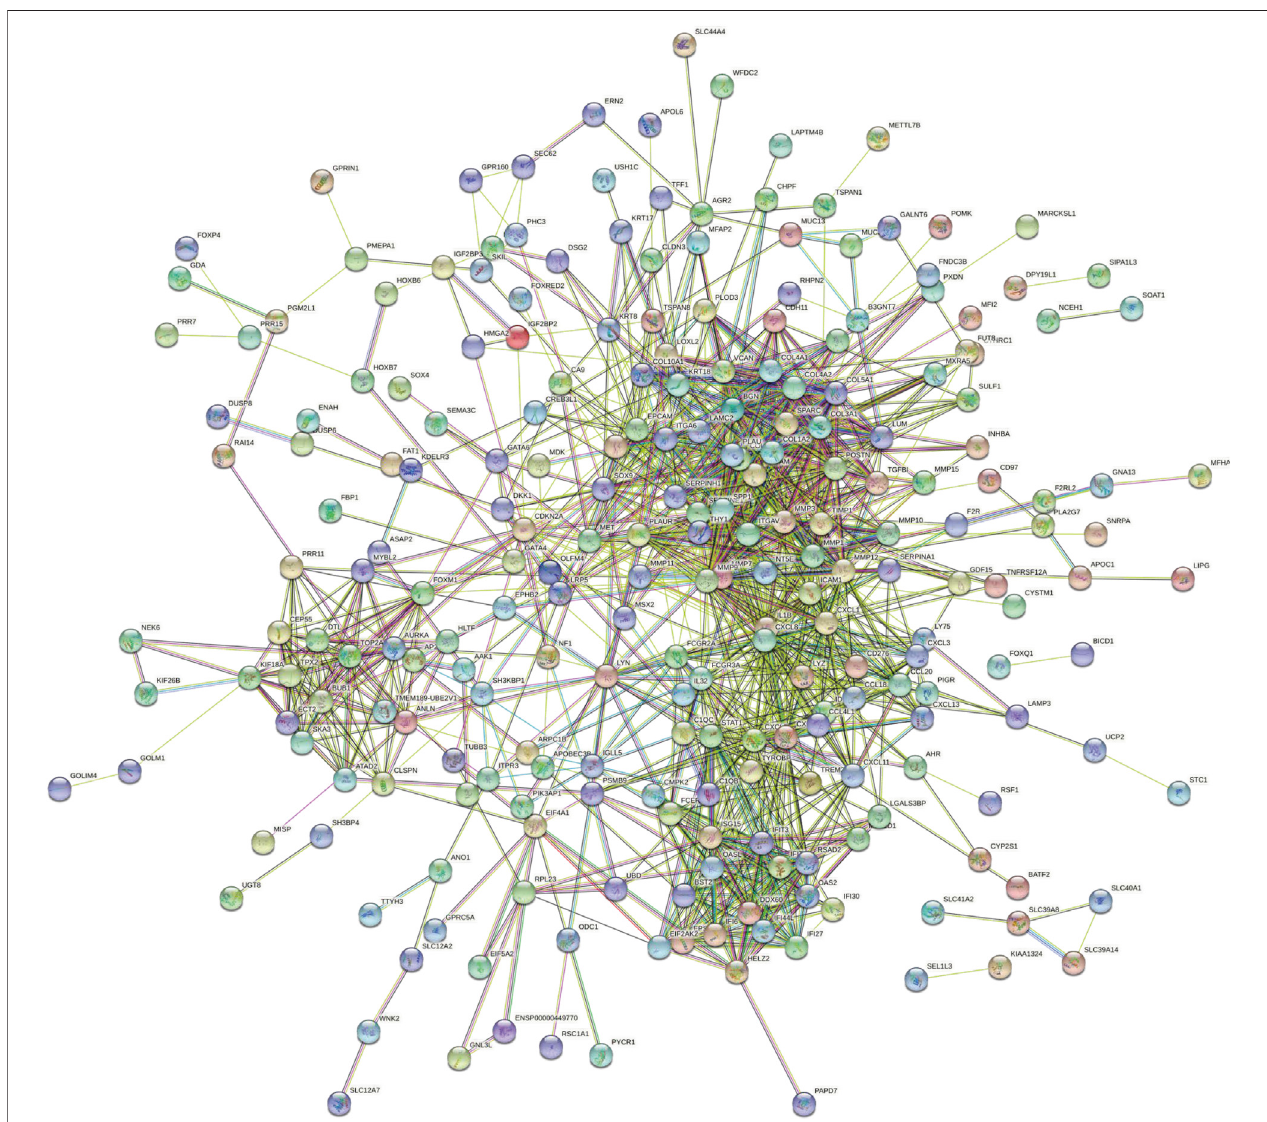
FIGURE 2 | PPI network for highly DEGs. PPI, protein – protein interaction; DEGs, differentially expressed genes.